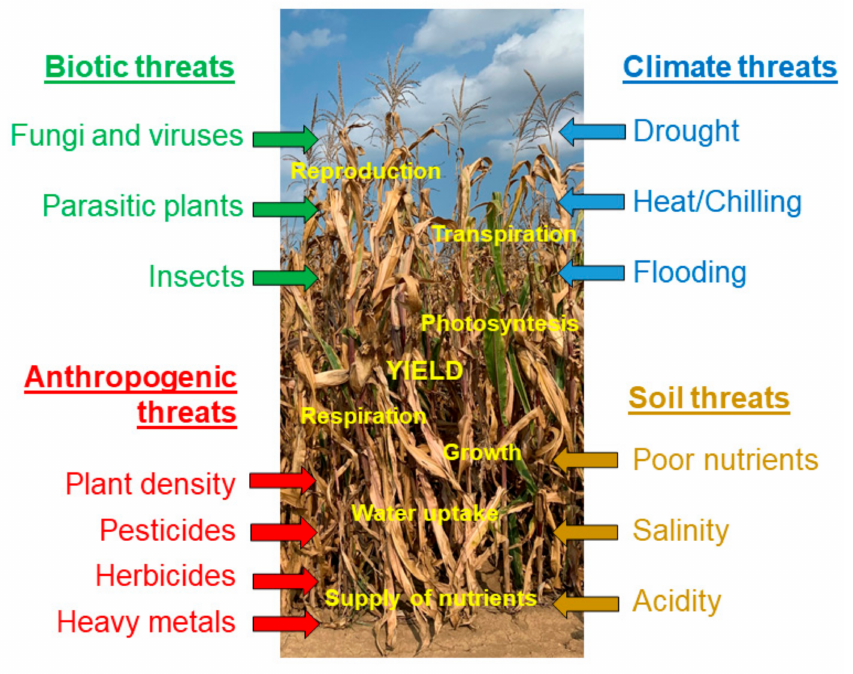
Figure 1. Most important stress factors in maize. Adapted from Zandalinas et al.